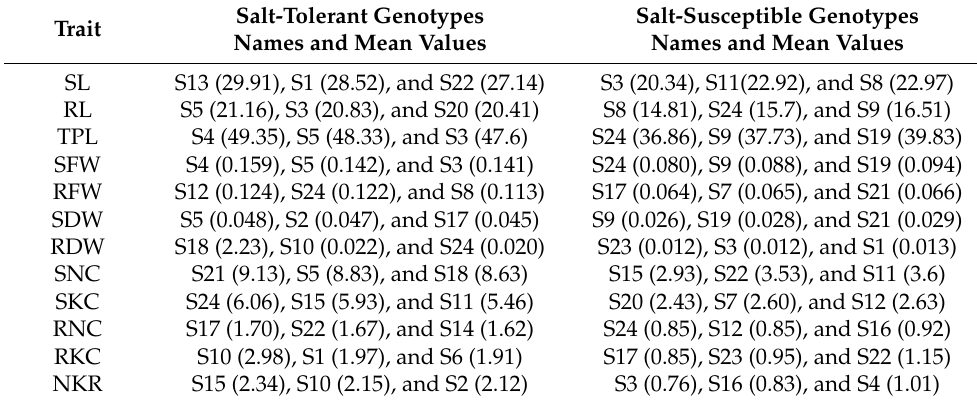
Table 2. Performance of 24 rice genotypes under 200 mM salt stress condition in glasshouse. Salt-Tolerant Genotypes Trait Names and Mean Values